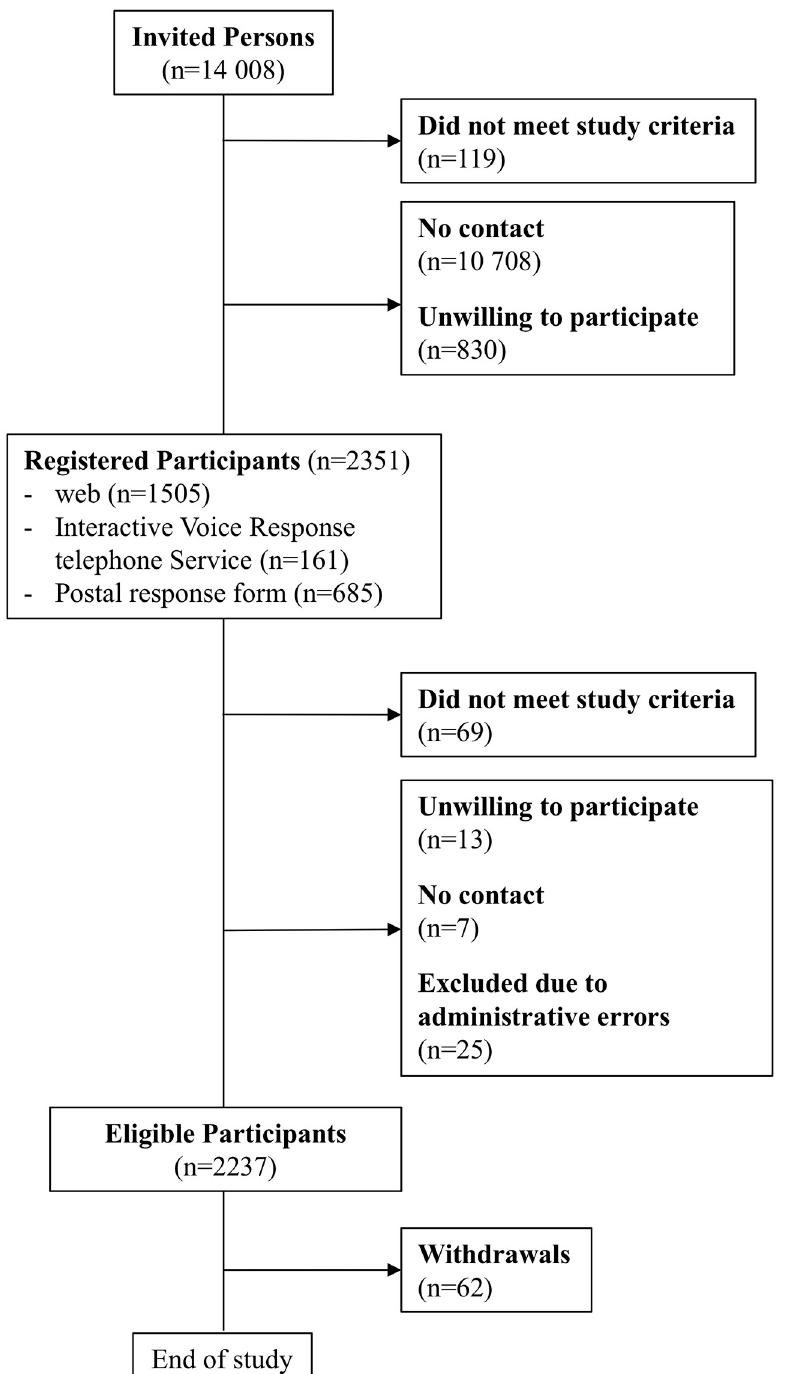
Fig 2. Study flow diagram of recruitment, enrolment and follow-up.